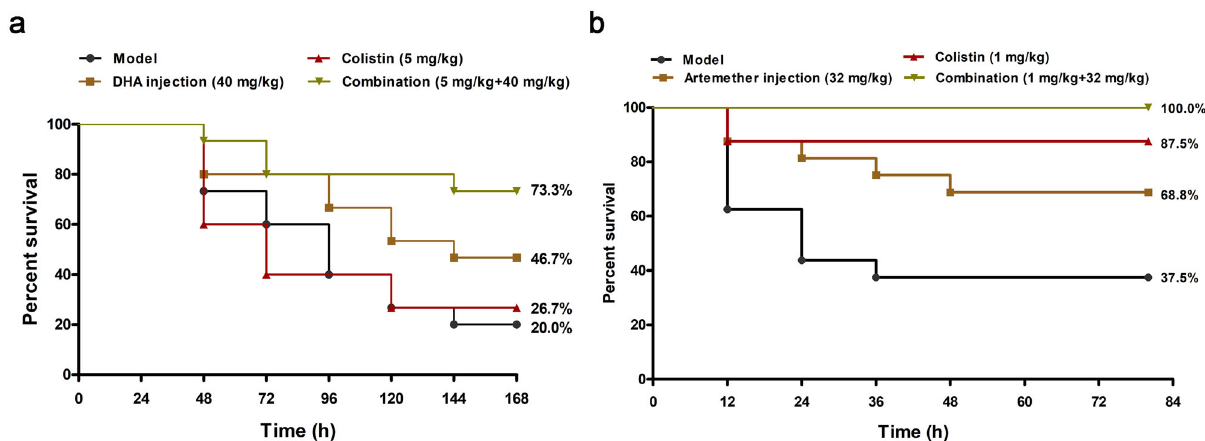
Fig. 10 Effects of DHA injection/artemether injection monotherapy or combination therapy against S. typhimurium HYM2 and A. baumannii ATCC19606. a , b The survival rates of mice infected with S. typhimurium HYM2 (15 mice per group) ( a ) and A. baumannii ATCC19606 (16 mice per group) ( b ) were monitored for 7 days post-infection. The data represent the means and standard deviations from three separate